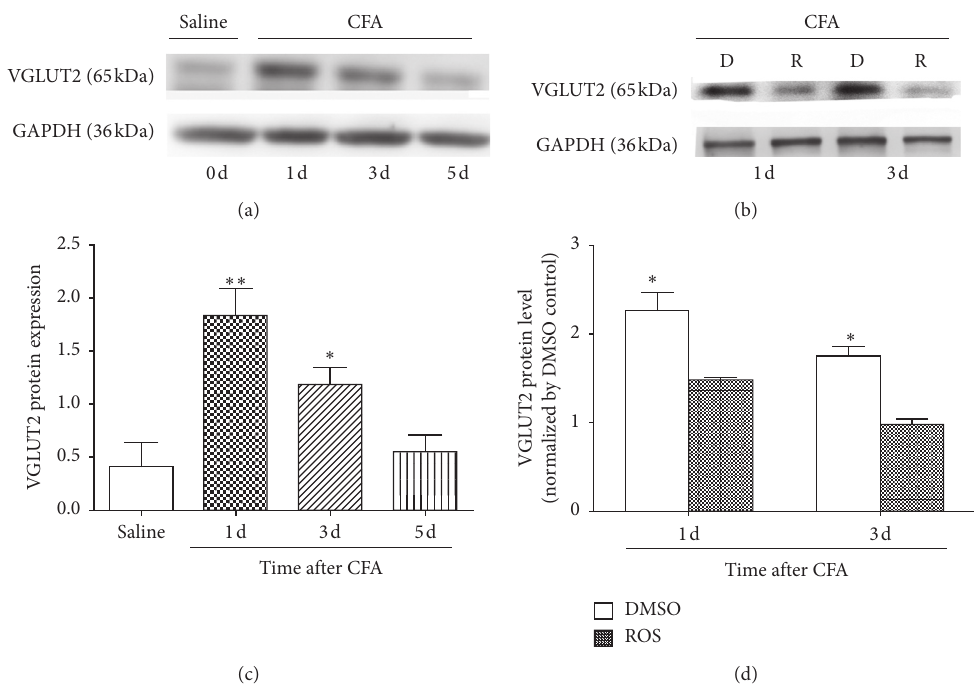
Figure 3: VGLUT2 protein expression was markedly increased in the DRG and reduced by roscovitine. Compared with the control group by intraplantar injection of saline, VGLUT2 expression was significantly increased from day 1 to day 3 following intraplantar injection of CFA. ∗ P < 0 . 05 and ∗∗ P < 0 . 01; n � 4/group A. Compared with the control group, by intrathecal injection of DMSO, the increased expression of VGLUT2 protein was significantly reduced by intrathecal injection of roscovitine between day 1 and day 3. Data shown represent mean ± SEM; ∗ P < 0 . 05; n � 4/group